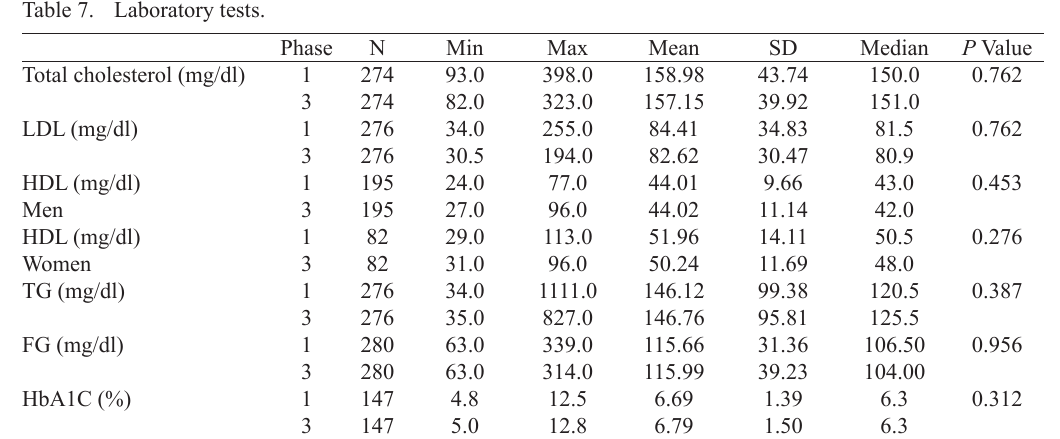
Table 7. Laboratory tests.